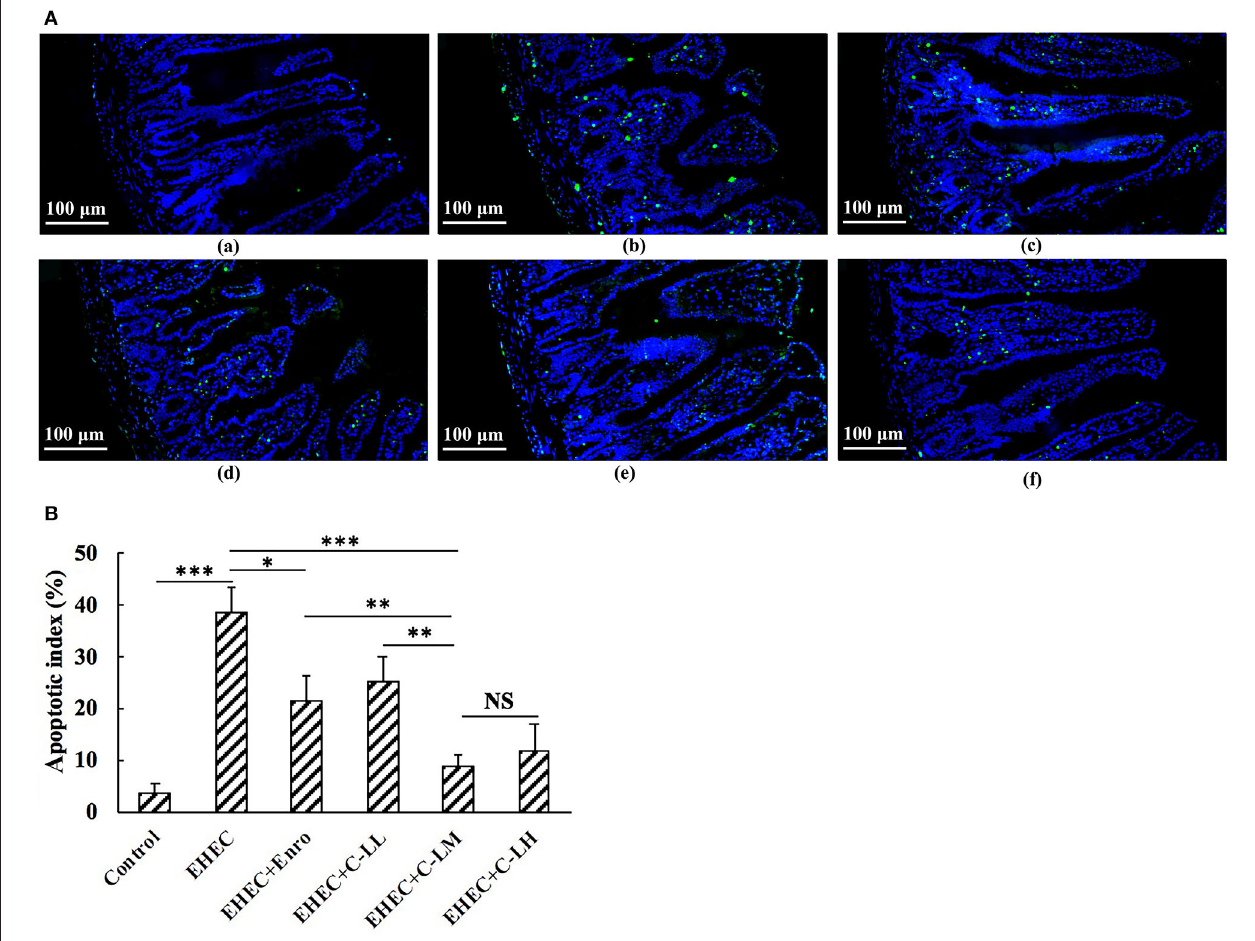
FIGURE 5 | TUNEL staining of jejunum tissues from the panel ( A -a) control, ( A -b) EHEC, ( A -c) EHEC + Enro, ( A -d) EHEC + C-LL, ( A -e) EHEC + C-LM, and ( A -f) EHEC + C-LH groups. (B) The numbers of apoptotic cells were counted based on the average number of positive (green) cells. Bar, 100 µ m. The control group was orally administered 100 µ L sterile PBS; the EHEC group was orally administered 100 µ L sterile PBS containing 1 × 10 8 CFUs EHEC O157:H7; the EHEC + Enro group was orally administered 100 µ L sterile PBS containing 1 × 10 8 CFUs EHEC O157:H7 and then treated by i.p. injection with 8 mg/kg Enro once/day for 3 days; the EHEC + C-LL, EHEC + C-LM, and EHEC + C-LH groups were administered 100 µ L sterile PBS containing 1 × 10 8 CFUs EHEC O157:H7 and then treated by i.p. injection with 4, 8, and 16 mg/kg C-L, respectively, once/day for 3 days. The data are shown as the mean ± standard deviation ( n = 8). NS, P > 0.05; * P ≤ 0.05; ** P ≤ 0.01; *** P ≤